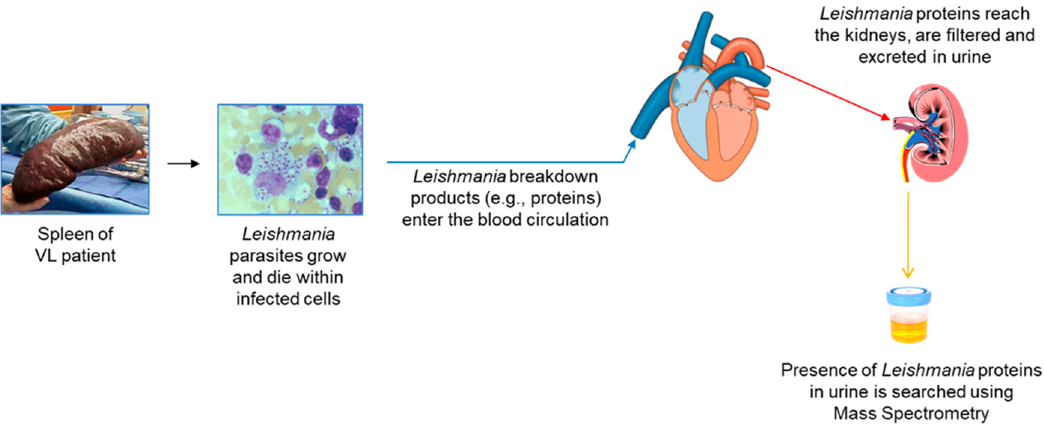
Figure 1. Illustration of conceptual idea and steps used to identify L. infantum L. donovani proteins in urine of patients with visceral leishmaniasis.